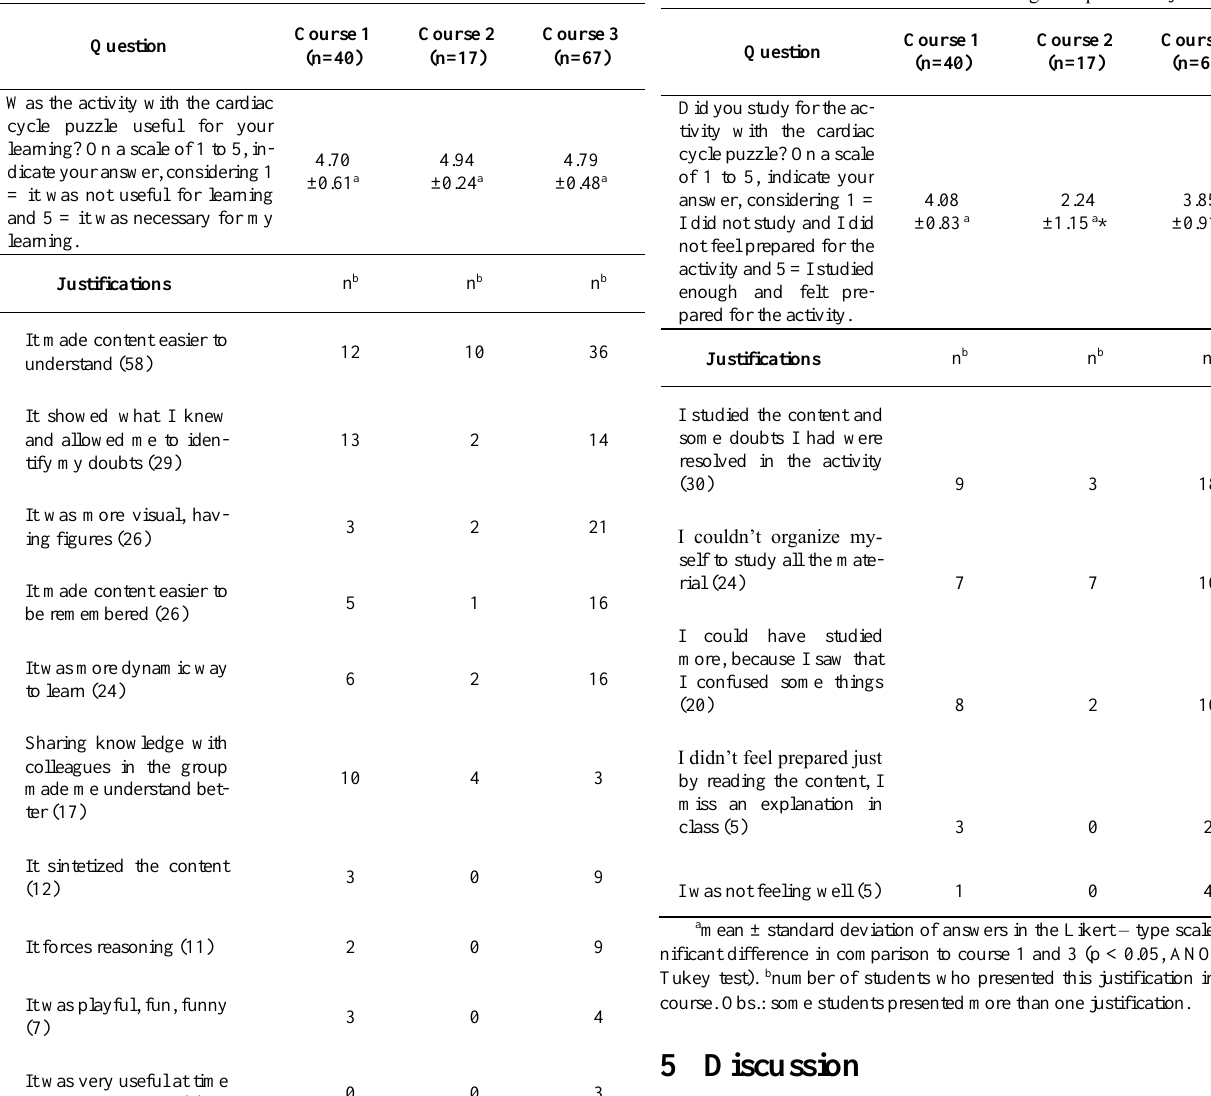
Table 1 . Students’ perception of the usefulness of the activity with the online digital version of the cardiac cycle puzzle for their learning. Table 2 . Students’ evaluation considering their pre-activity